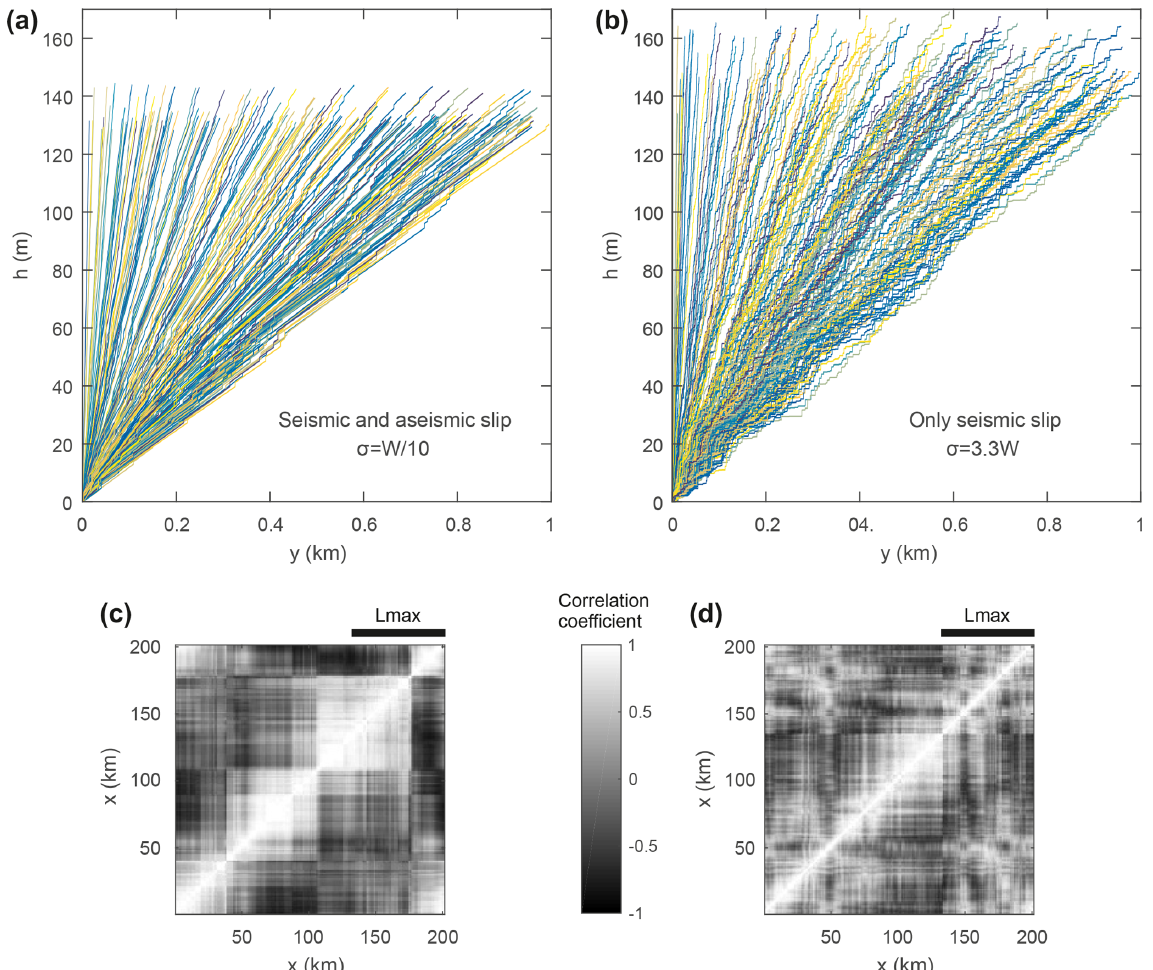
Figure B1. Correlation matrixes showing the coefficient of correlation in between the 200 river profiles shown in Fig. 8a and b, respectively. The correlation is performed on detrended river profiles. Panel (a) shows results of the “only seismic slip” model, while panel (b) shows results of the “seismic and aseismic slip”